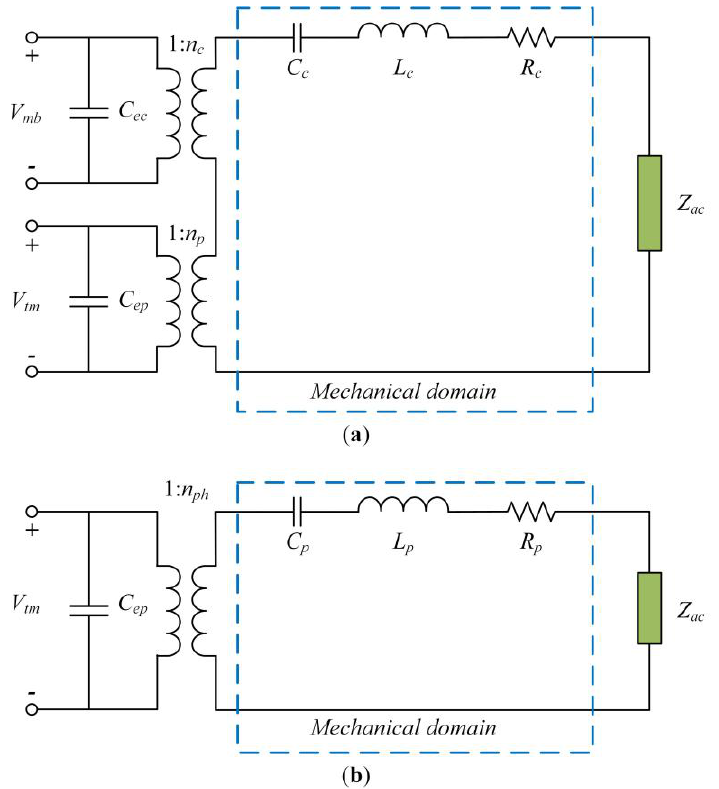
Figure 5. Electrical equivalent circuits of the DFUT, ( a ) at the CMUT operation; ( b ) at the PMUT operation.